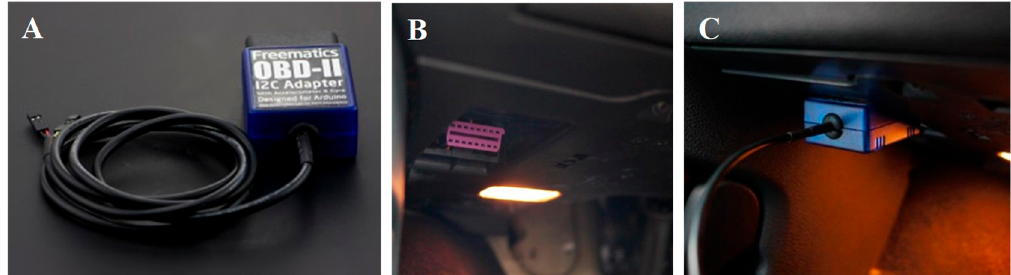
Figure 3. ( A ) On-board diagnostics (OBD)-II module, ( B ) OBD-II port, and ( C ) OBD-II module connected to the car’s OBD-II port.